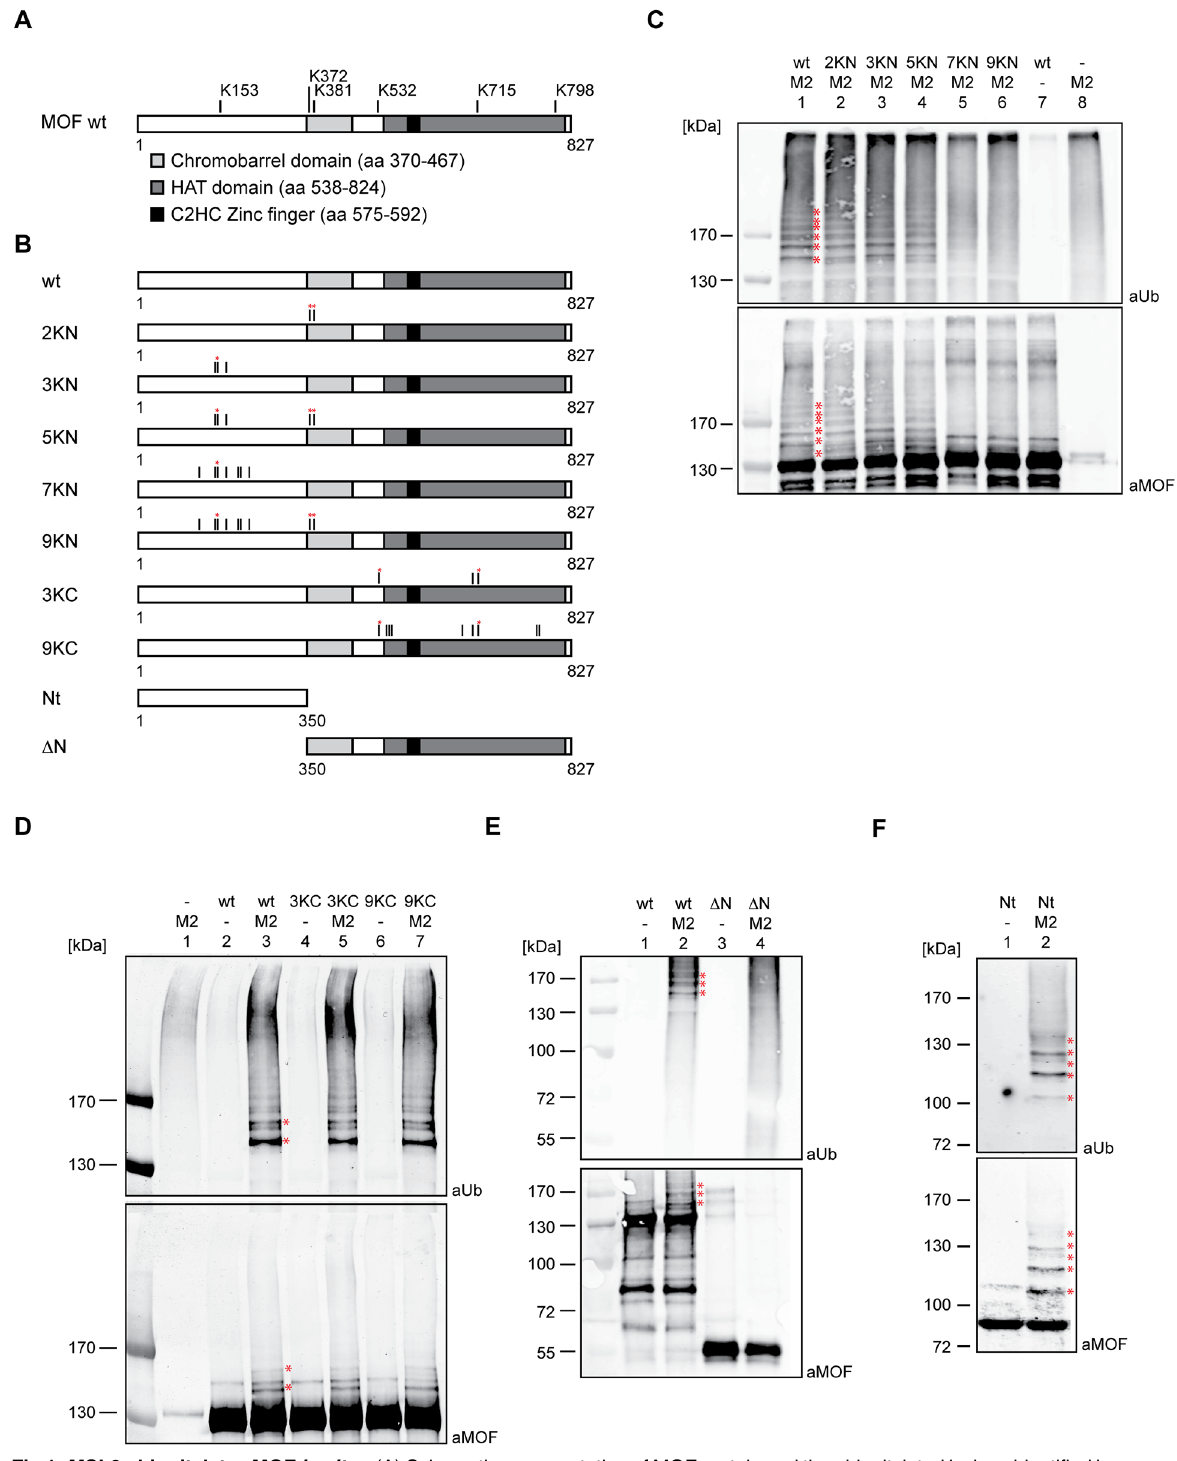
Fig 1. MSL2 ubiquitylates MOF in vitro . (A) Schematicrepresentation of MOF protein and the ubiquitylated lysines identifiedby mass spectrometry in vitro. MOF containsan unstructured N-terminal region, a globularchromobarreland a histoneacetyltransferase domains(light and dark gray box, respectively). MOF comprisesa C2HC Zinc finger within the histone acetyltransferase domain(black box). Lysines that are ubiquitylated by MSL2 are indicated.Bold bars mark ubiquitylation found in 3 out of 3 biological replicates, dashed bars point to ubiquitylation only detected in 1 out of 3 experiments. (B) Schematic representation of MOF mutants generatedin